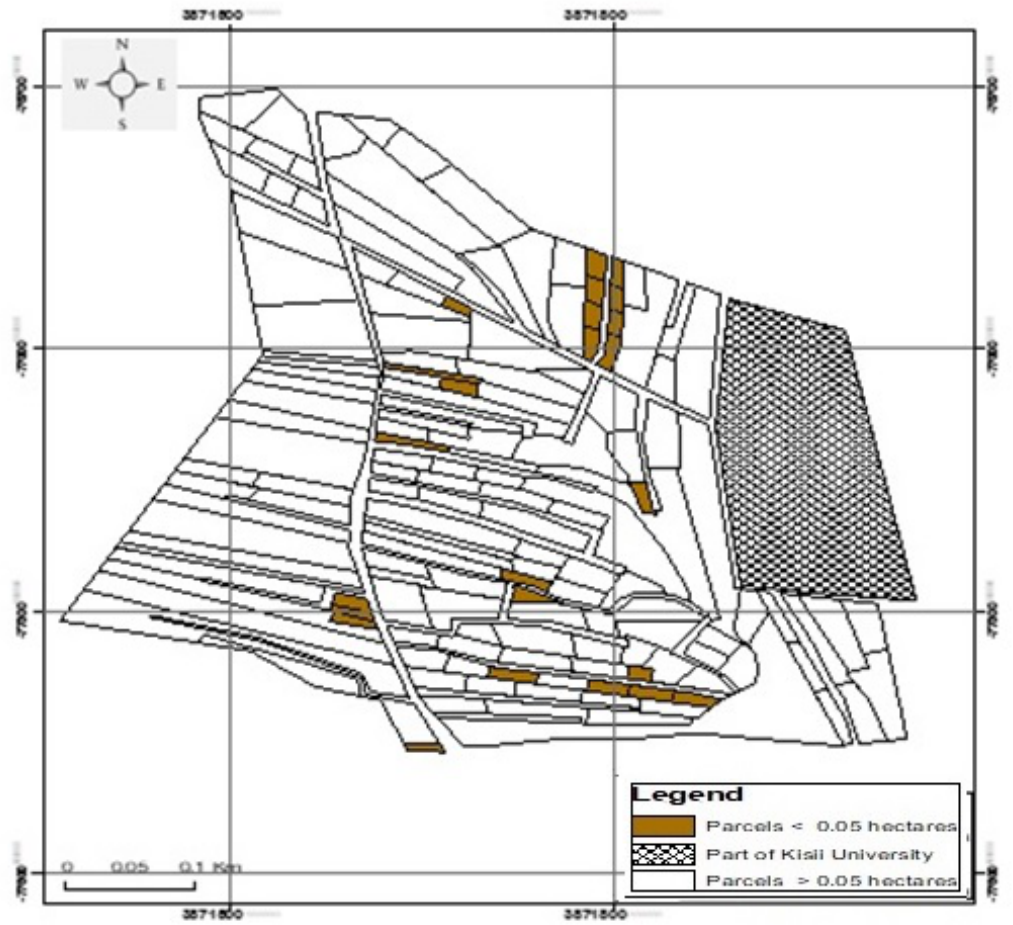
Fig. 6: Noncomplying land subdivisions in